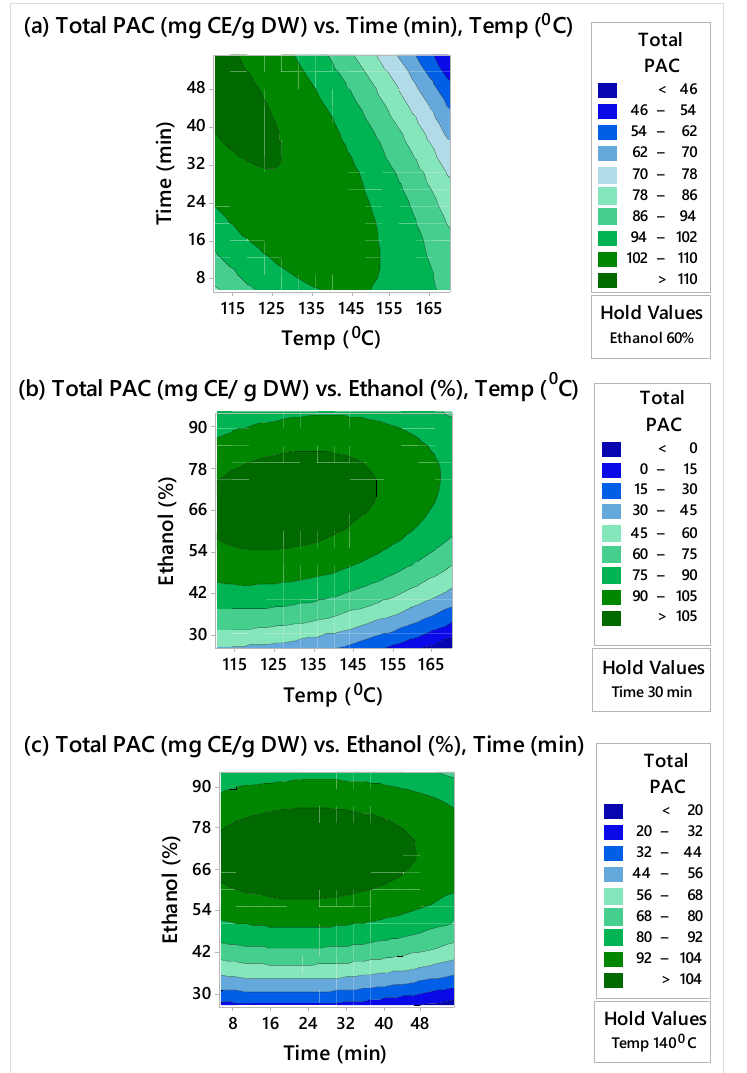
Figure 2. Contour plots of total PACs (mg CE / g DW) vs. ( a ) time (min) and temperature (C) with ethanol held at 60%, ( b ) ethanol (%) and temperature (°C) with time held at 30 min, and ( c ) ethanol (%) and time (min) with temperature held at 140 °C.